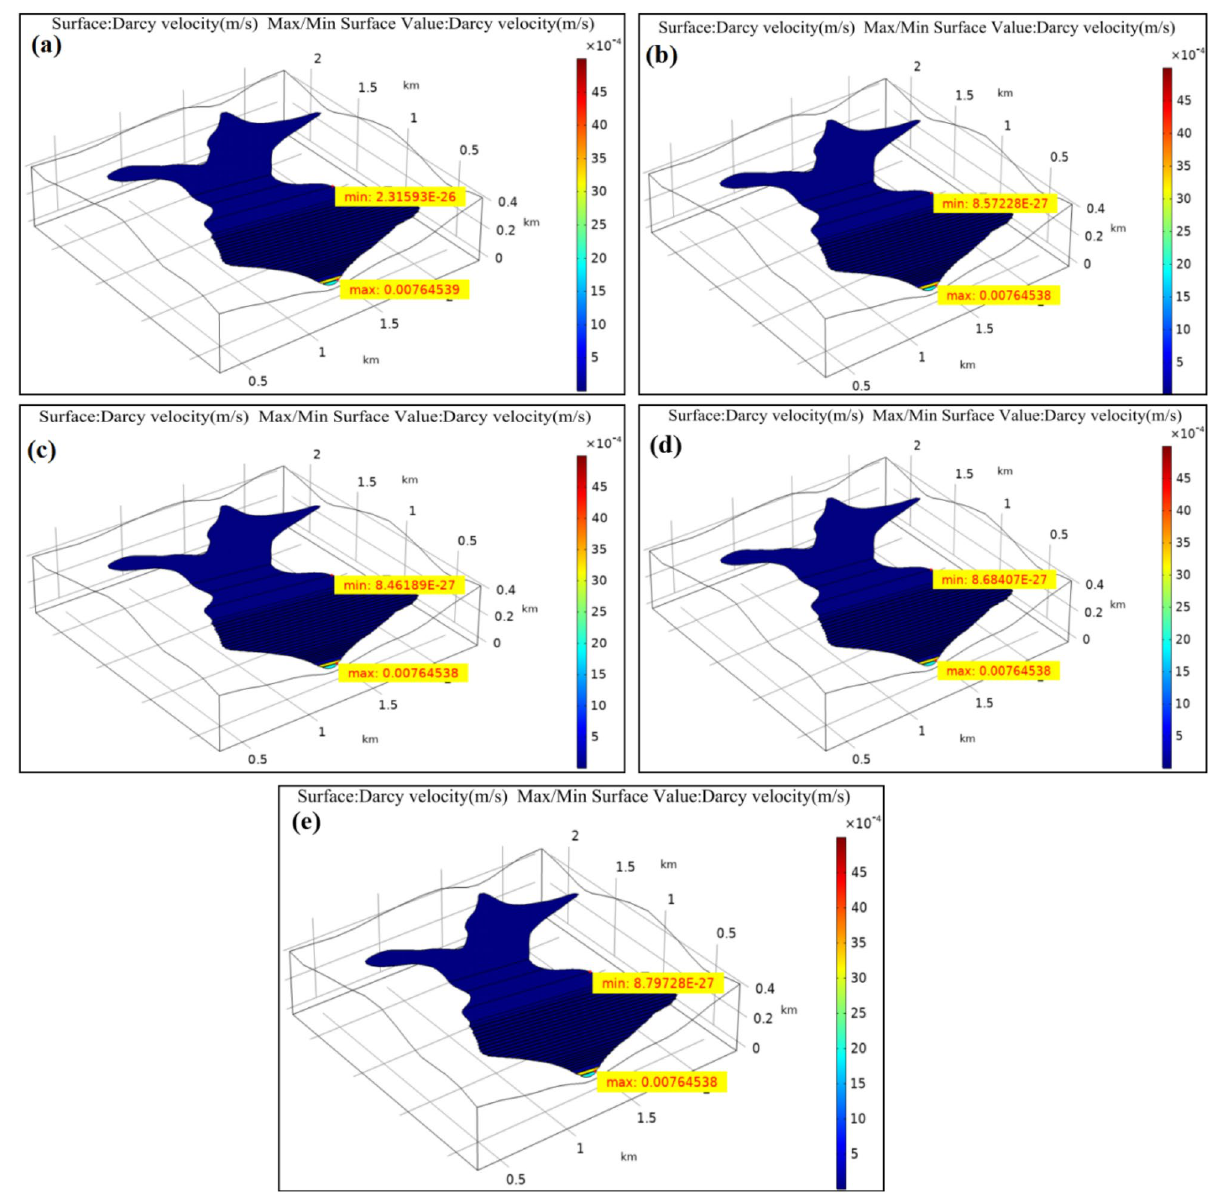
Figure 3. Velocity field distribution of the tailings dam under different pH values conditions. ( a ) pH = 7 (original sample); ( b ) pH = 3; ( c ) pH = 5; ( d ) pH = 9; ( e ) pH =